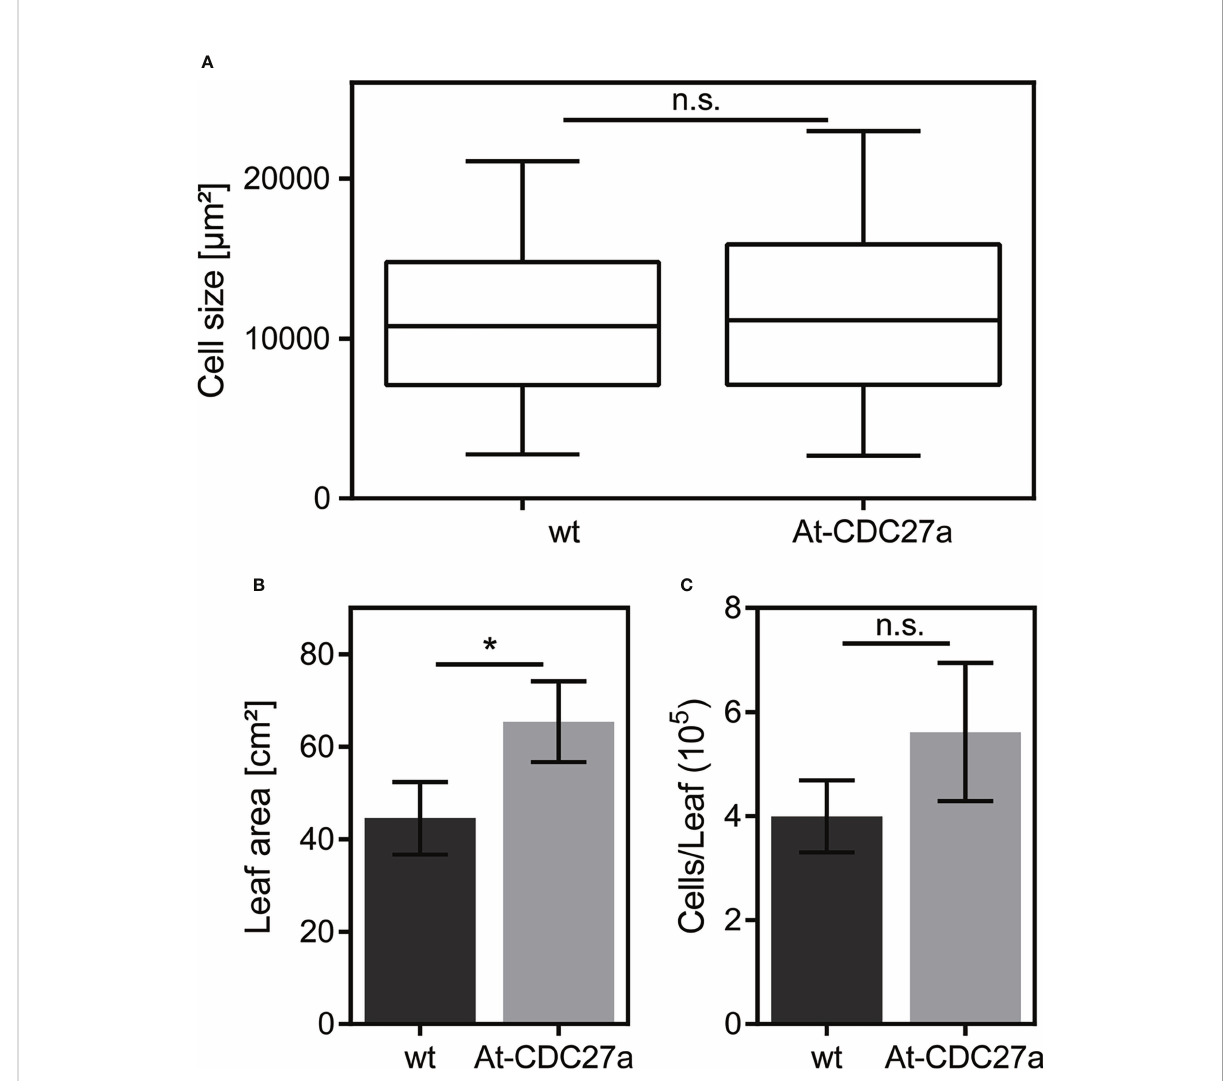
FIGURE 4 Cellular parameters of the At-CDC27a-29 and wild type N. benthamiana leaves. Epidermal cell (A) , leaf size (B) and number of cells per leaf (C) were determined in the third leaf of the At-CDC27a-29 and non-transgenic control plants (n=3). Values represent the means with standard deviation. Asterisks indicate signi fi cance with * p < 0.05. Not signi fi cant values are determined as